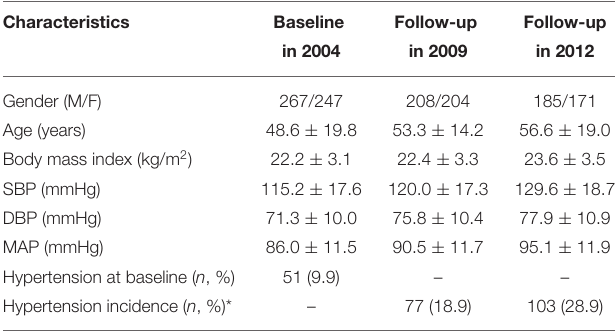
TABLE 1 | Characteristics of the study participants at baseline and during follow-ups in the longitudinal cohort study.